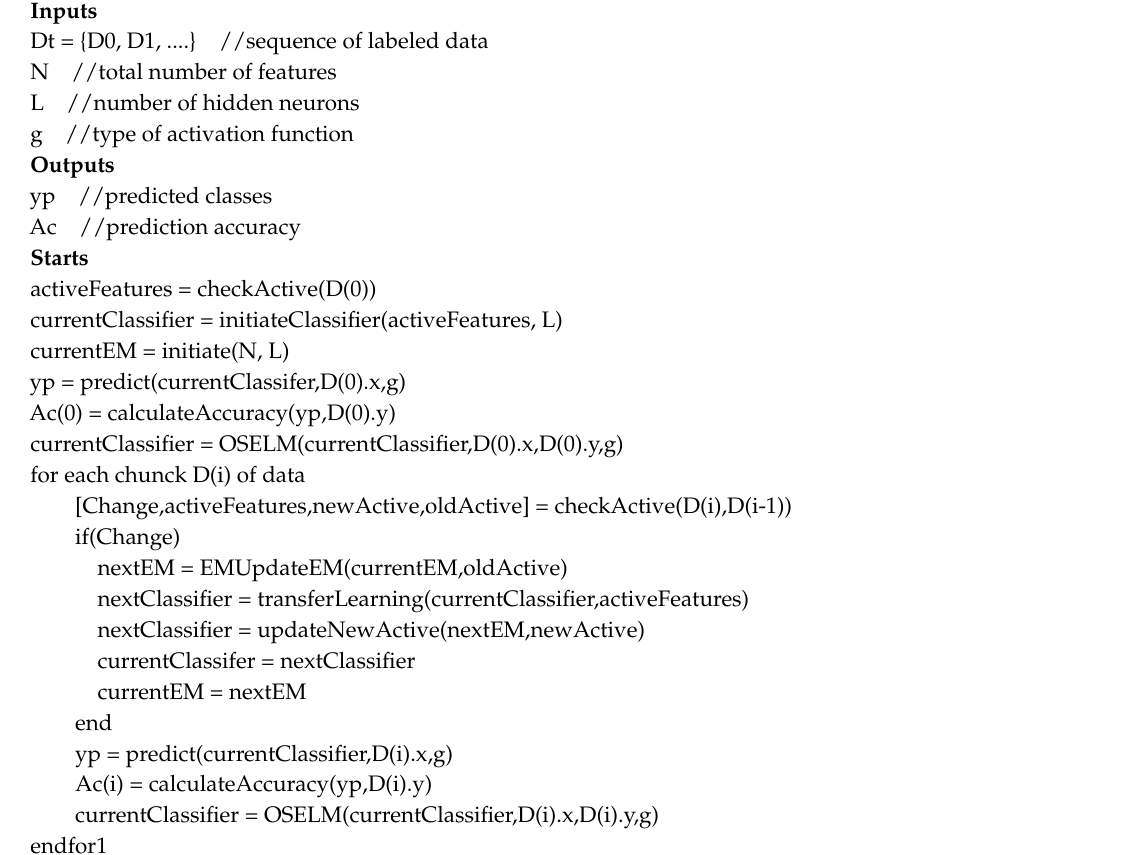
Algorithm 2. Pseudocode for the ITM-OSELM algorithm used to calculate